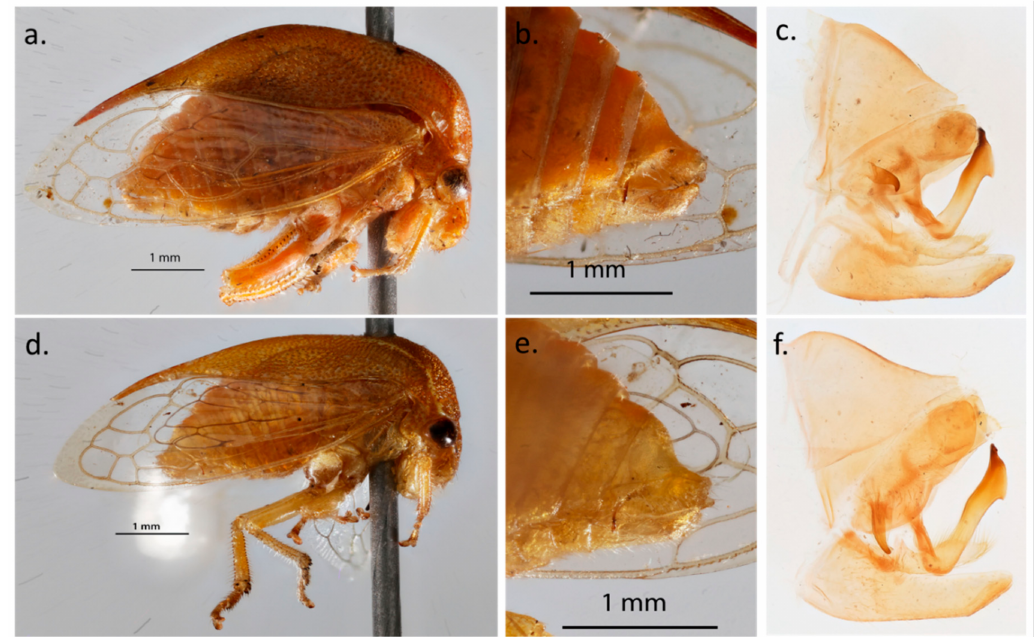
Figure 3. Comparative observations of Spissistilus festinus specimens collected from (top panels) soybean in Auburn, Alabama, and (bottom panels) alfalfa in Lodi, California. Full body side view ( a , d ), and lateral view of the male terminalia ( b , e ) and dissected genitalia ( c , f ). Note the less elevated pronotum of the specimen from California compared to the specimen from Alabama.